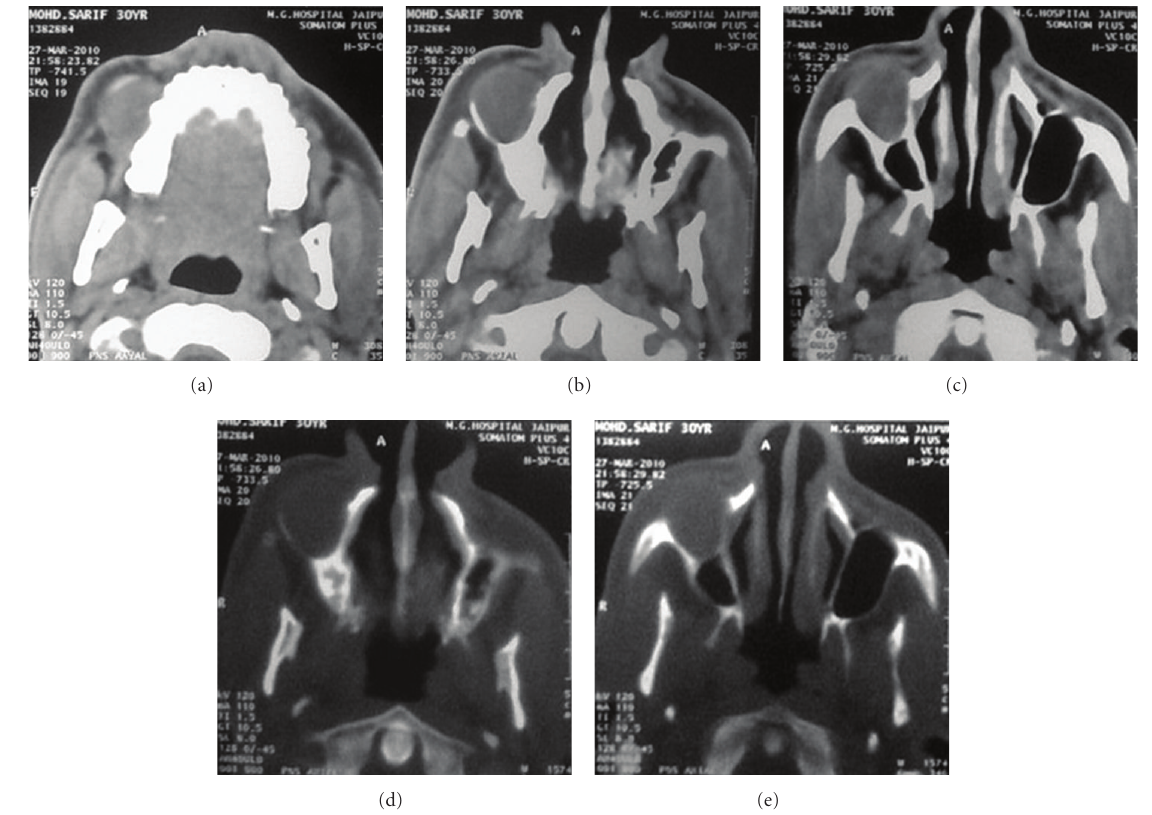
Figure 9: (a, b, c) CT scan view (Axial section soft tissue window), (d, e) CT scan view (Axial section bone window). Both views show a well-defined soft tissue lesion causing displacement of anterolateral wall of the right sinus with involving it.